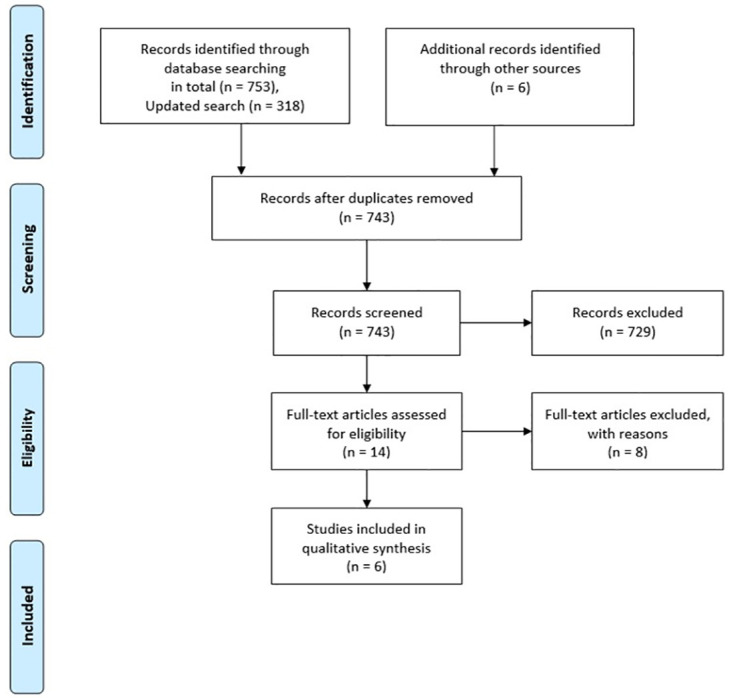
PRISMA flow diagram.